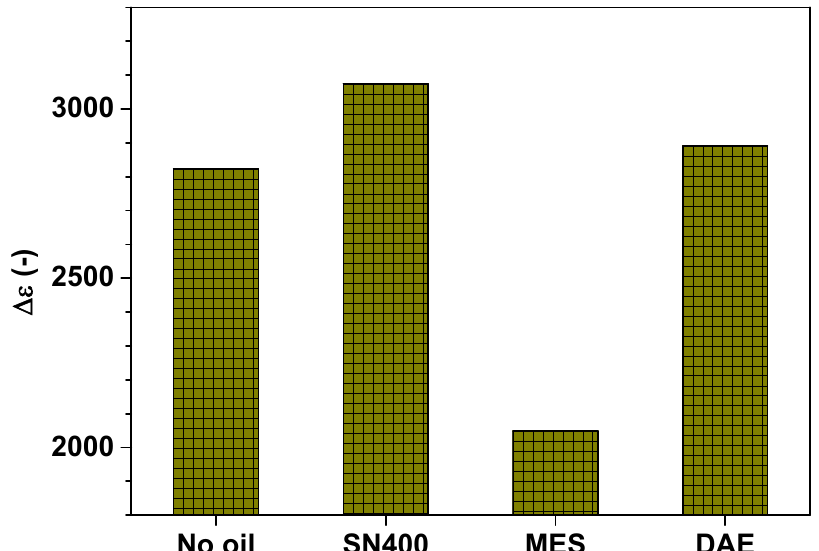
Figure 11. Infinite-frequency dielectric permittivity ε inf of the SBR samples determined by means of Figure 11. Infinite ‐ frequency dielectric permittivity 𝜀 (cid:2919)(cid:2924)(cid:2916) of the SBR samples determined by means simultaneous mechanical and dielectric measurements at 24 ◦ C under a static force of 10 N. of simultaneous mechanical and dielectric measurements at 24 °C under a static force of 10 N.